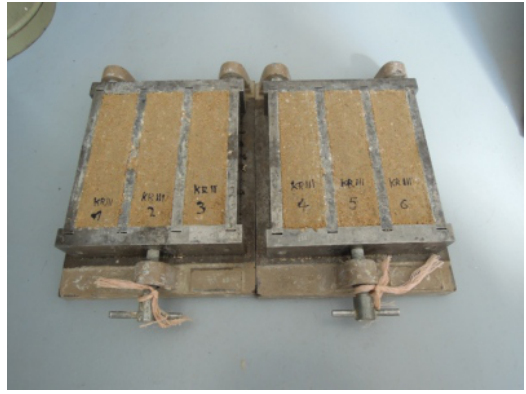
Figure 1. Granularity curve.